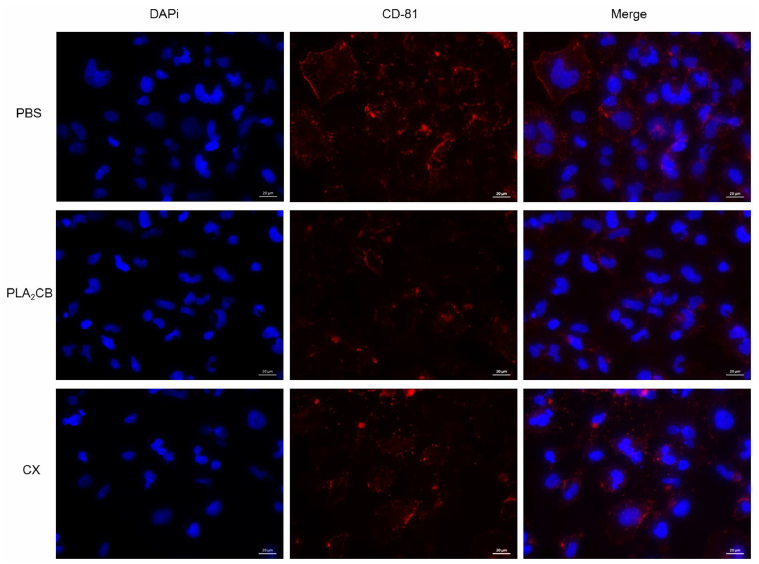
Fig 7. Effect of toxins on CD81 cell receptors. Huh-7.5 cells were incubatedwith CD81/TAPA1 antibody and 10 μ g/ml of CX, PLA 2 -CB or PBS. Then cells were washedand incubatedwith secondary antibody Alexa Fluor 594. Cells were fixed with 4% paraformaldehydeand labelledfor nucleiwith DAPI and analyzedon Fluorescence microscopy ZEN lite 2012.